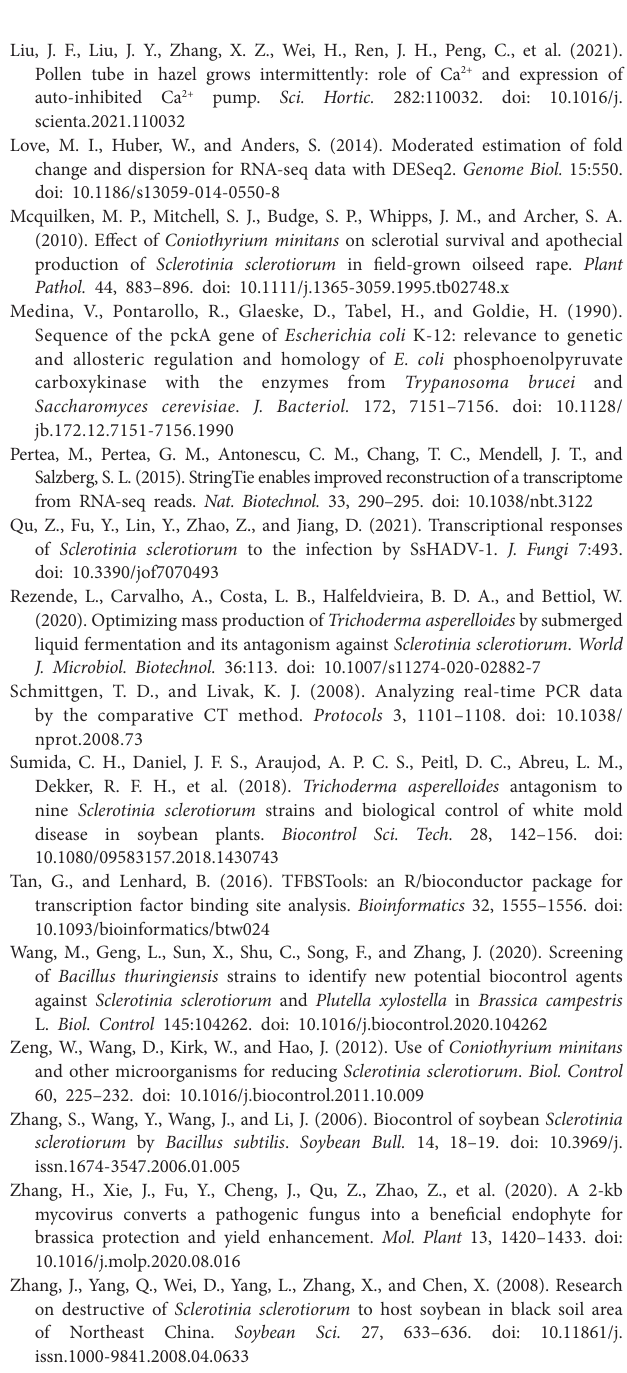
Supplementary Table S3 | Alignment statistics of Sclerotinia sclerotiorum . Supplementary Table S4 | Alignment statistics of Bacillus amyloliquefaciens . Supplementary Table S5 | Transcript expression abundance of Sclerotinia sclerotiorum . Supplementary Table S6 | Transcript expression abundance of Bacillus amyloliquefaciens